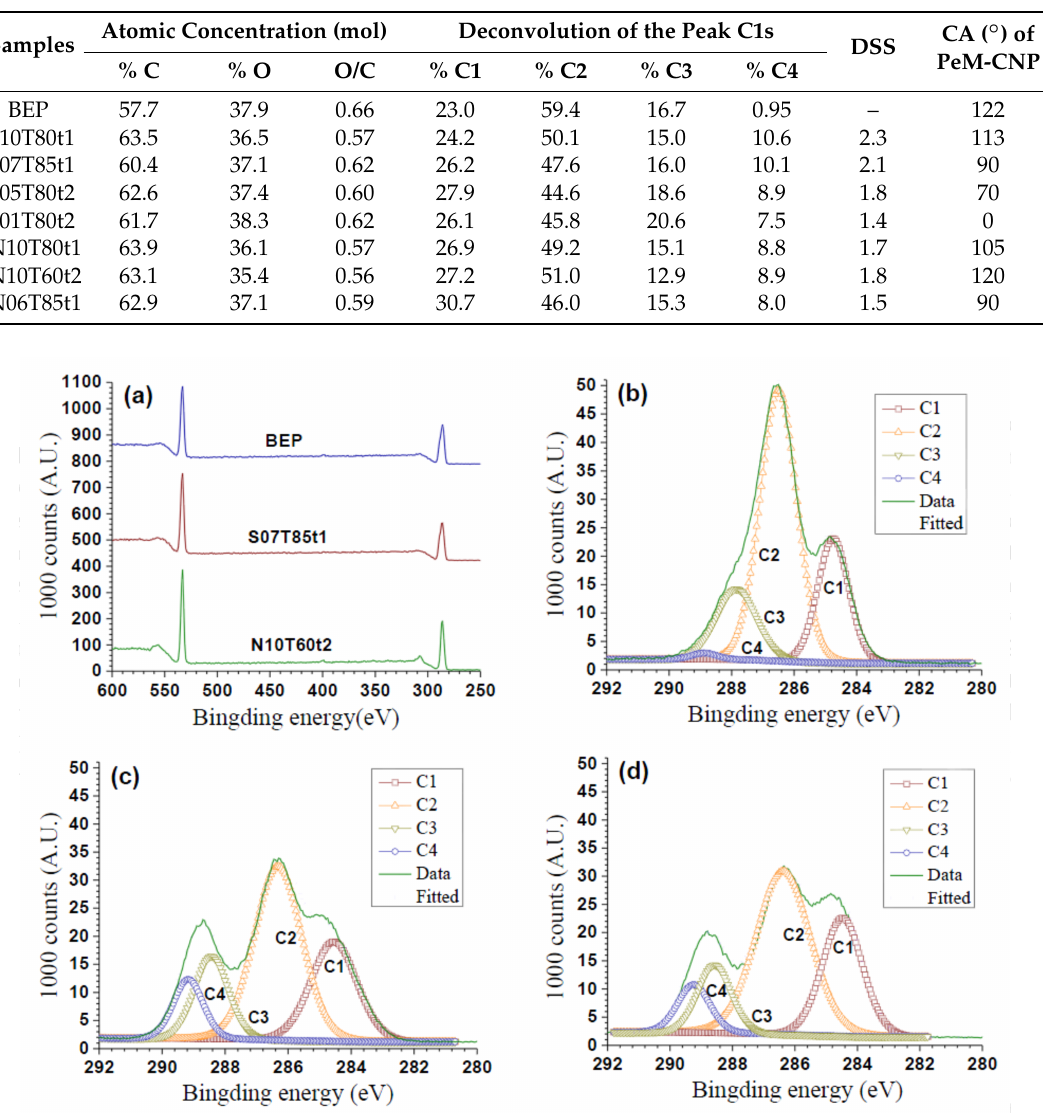
Table 4. Element percent and deconvolution of the peak C1s from the X-ray photoelectron spectra (XPS) analysis for BEP and PeM-CNP samples and degree of surface substitution (DSS).